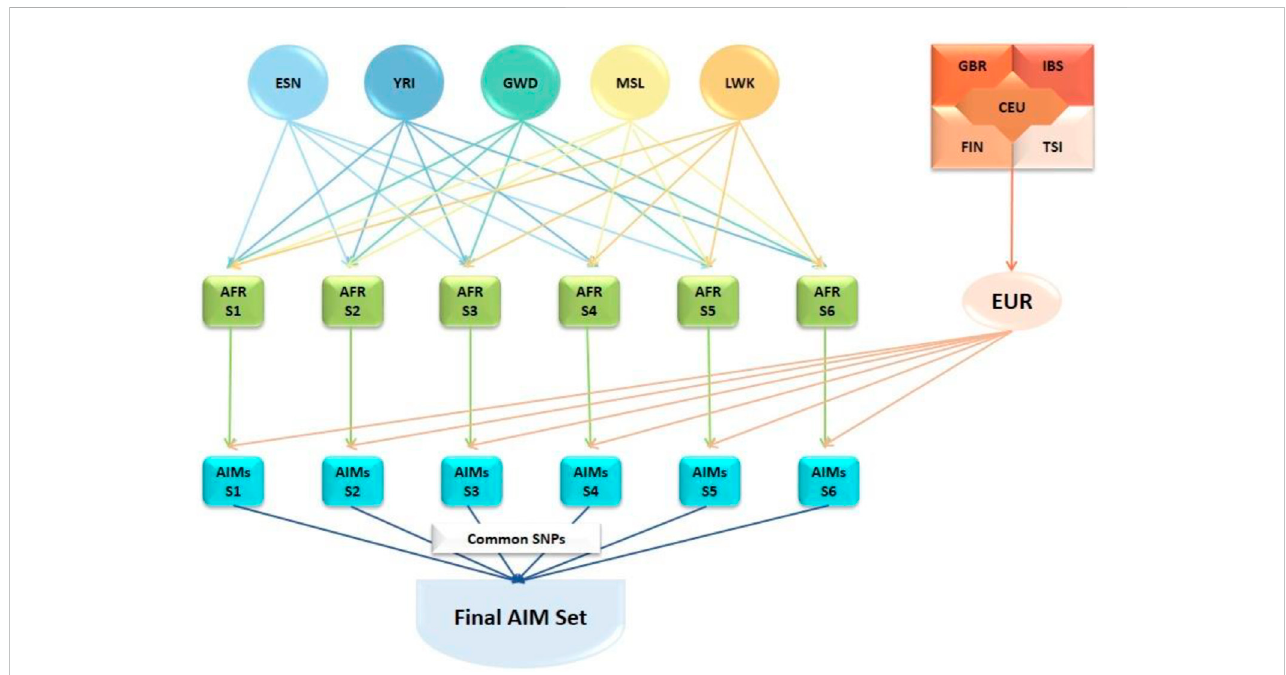
FIGURE 1 Development of the African AIMs panel for this study. Genotype data from African (AFR) populations (Gambian, Gambia [GWD]; Esan, Nigeria [ESN]; Luhya,Kenya[LWK];Mende,SierraLeone[MSL];Yoruba,Nigeria[YRI])andEuropean(EUR)populations(UtahresidentswithEuropeanancestry[CEU];Finnish, Finland [FIN], British; England & Scotland [GBR]; Iberian, Spain [IBS]; Tuscany, Italy [TSI]) from the 1000 Genomes Project database. AFR dataset combinations (AFR-S1 to AFR-S6) and the combined EUR dataset were generated based on the ancestry informativeness (ln) of each variant. Genetic variants with In ≥ 0.25 were considered as AIMs. Each AFR subset was compared against the combined EUR set resulting in six different AIMs subsets. The SNPs common to all six AIMs subset were extracted to generate the set of 46,737 African AIMs used in this